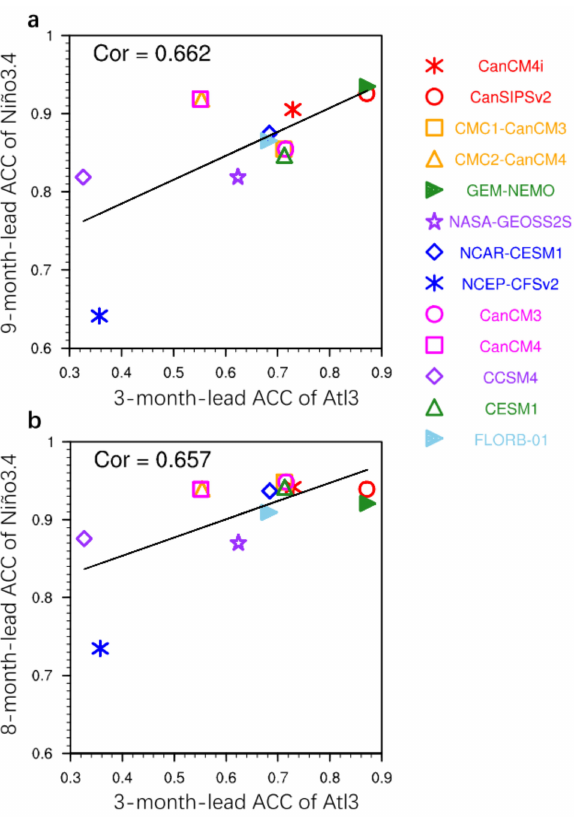
Figure 15. Scatter diagram showing the relationship between ( a ) the three-month-lead ACC of the Atl3 index ( x -axis) and the nine-month-lead ACC of the Niño3.4 index ( y -axis). To specifically examine the relationship between the prediction skills of Atlantic Niño/Niña and ENSO (or the SST anomalies in the central-eastern equatorial Pacific), here the ACC is calculated based on the selected Atlantic Niño and Niña years, and the June–July averaged Atl3 index is chose for verifying the Atlantic Niño/Niña prediction skill and the preceding December–February averaged Niño3.4 index is chosen for verifying the preceding ENSO prediction skill. ( b ) same as ( a ) but for 8-month-lead ACC of Niño3.4 index. Note that the ACC results with different lead time generally show same positive correlation between